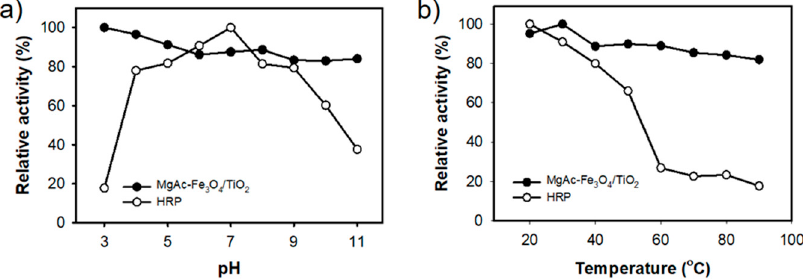
Figure 5. Stabilities of MgAC-Fe 3 O 4 /TiO 2 and HRP with varying ( a ) pH and ( b )